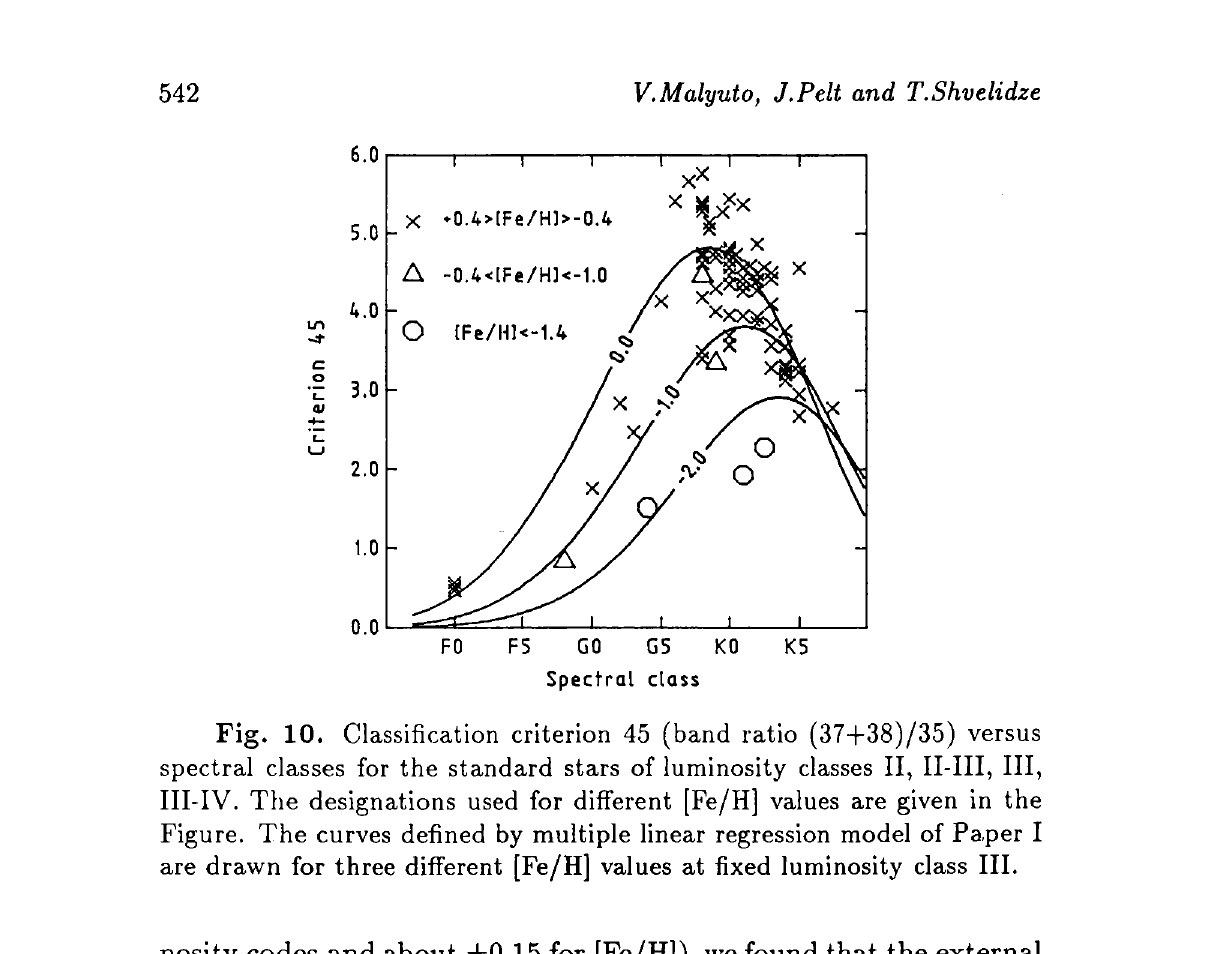
Fig. 10. Classification criterion 45 (band ratio (37+38)/35) versus spectral classes for the standard stars of luminosity classes II, II-III, III, III-IV. The designations used for different [Fe/H] values are given in the Figure. The curves defined by multiple linear regression model of Paper I are drawn for three different [Fe /H] values at fixed luminosity class